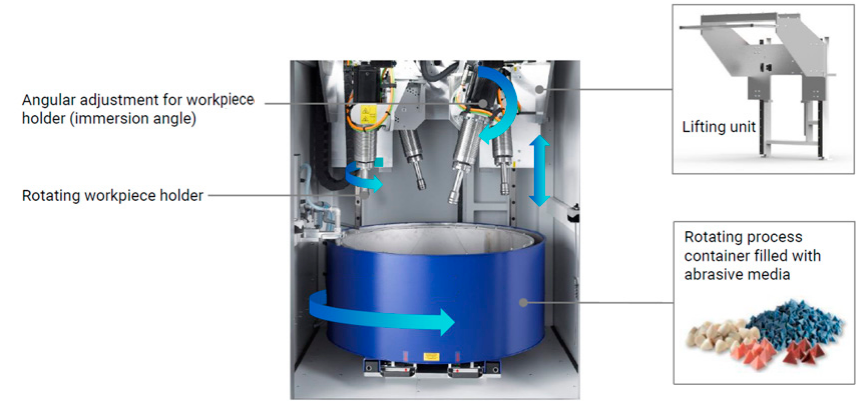
Figure 2. Stream Finishing process equipment [17].